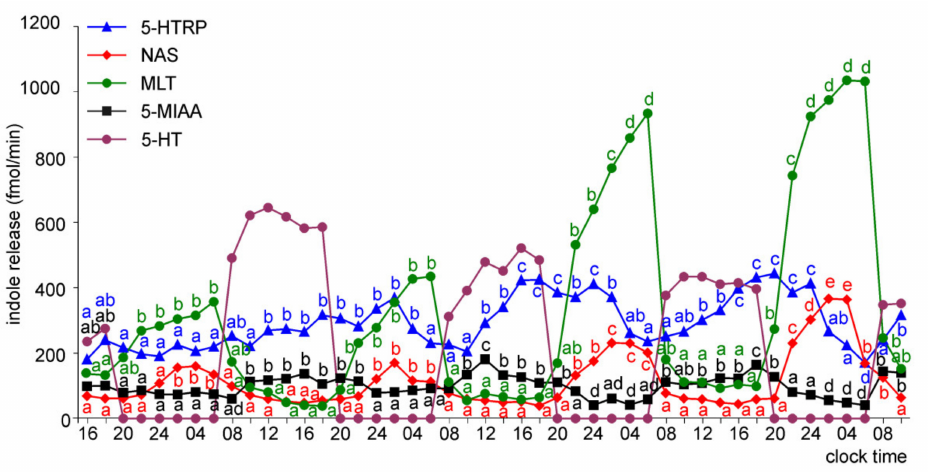
Figure 15. Release of 5-HTRP, NAS, MLT, and 5-MIAA (means, n = 3) from pineal organs of ED 26 embryos incubated under a 12L:12D cycle and treated with NE during photophase. The same letters indicate means, which are not significantly different between